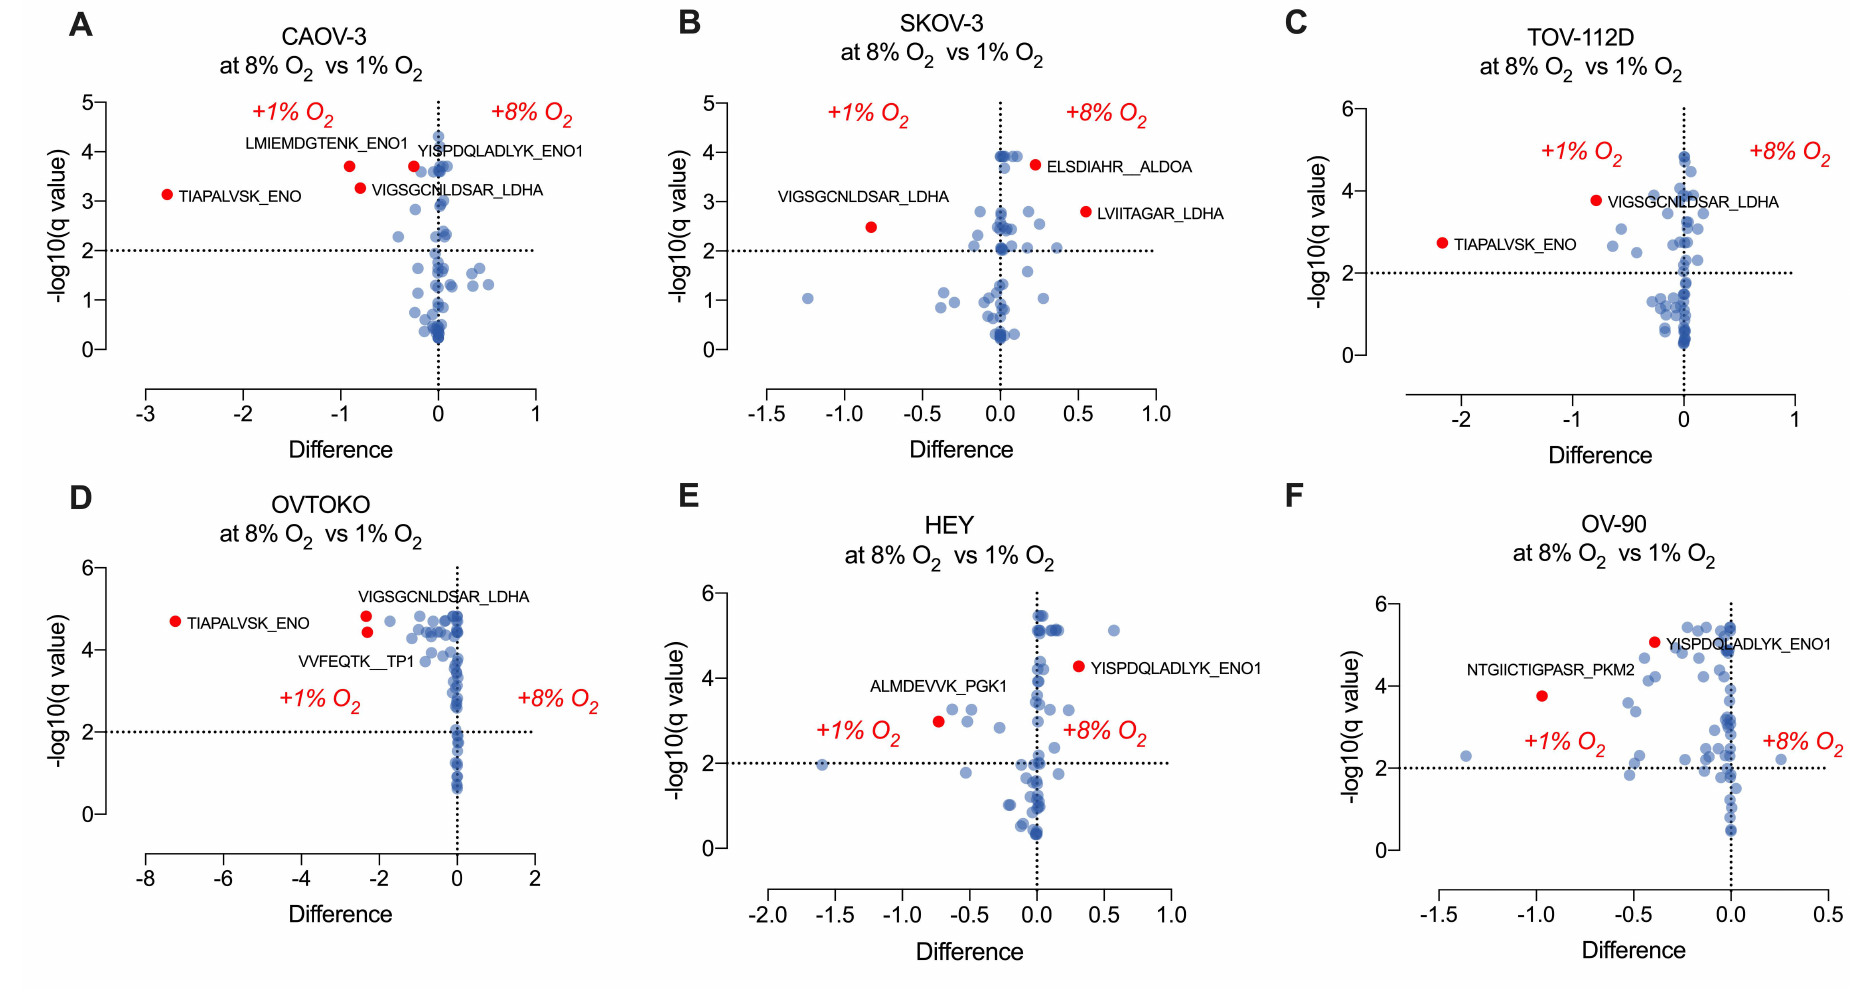
Figure 6. Relative quantification of the glycolysis proteome in ovarian cancer cells in response to oxygen tensions. Ovarian cancer cells were cultured under 8% or 1% oxygen, and the protein abundance associated with glycolysis were quantified using a targeting mass spectrometry approach. ( A ): CAOV-3; ( B ): SKOV-3; ( C ): TOV-112D; ( D ) OVTOKO; ( E ) HEY; and ( F ) OV-90. Volcano plots show the differences in peptides associated with proteins representatives of glycolysis proteome in cells cultured at 8% compared with cells cultured at 1%